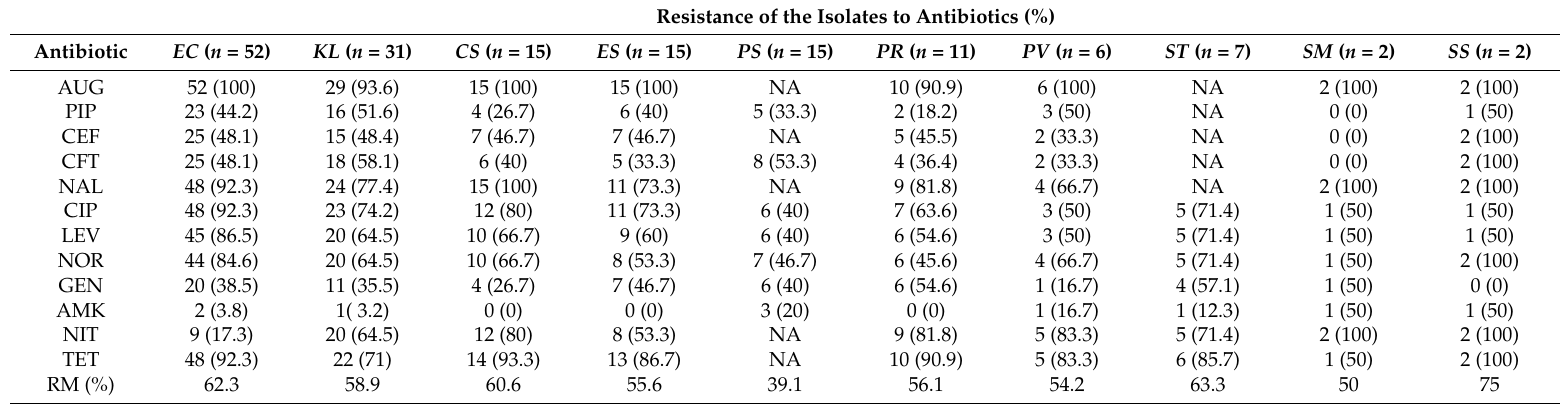
Table 3. The prevalence of antimicrobial resistance among bacterial